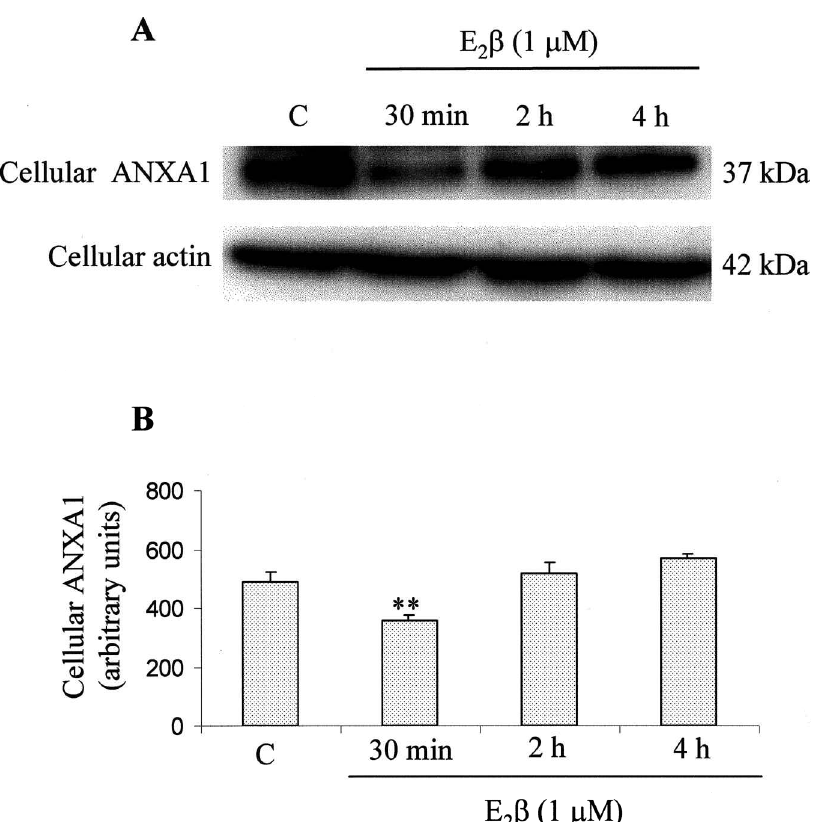
FIG. 4. Effect of E2 b on cellular ANXA1 protein expression in CCRF-CEM cells. Cells were incubated in the absence (control, C) or in the presence of E 2 b (1 m M), for 30min, 2h and 4h. The cellular content of ANXA1 was determined by Western blot analysis (A), and the bands were quantified with an image analyser (B). Detection of cellular ANXA1 protein was achieved using a mouse monoclonal anti-ANXA1 antibody. The data shown are an average of three independent experiments. Values are mean±SD, ** p < 0.01 as determined by one-way ANOVA with Dunnett’s post